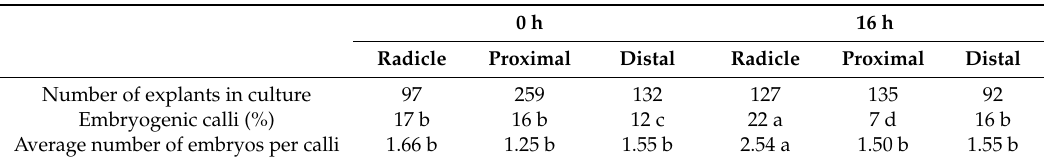
Table 2. Percentage of embryogenic calli and the average number of somatic embryos achieved per explant in OMc medium without growth regulators. Di ff erent letters correspond to statistically significant di ff erences ( p ≤ 0.05).